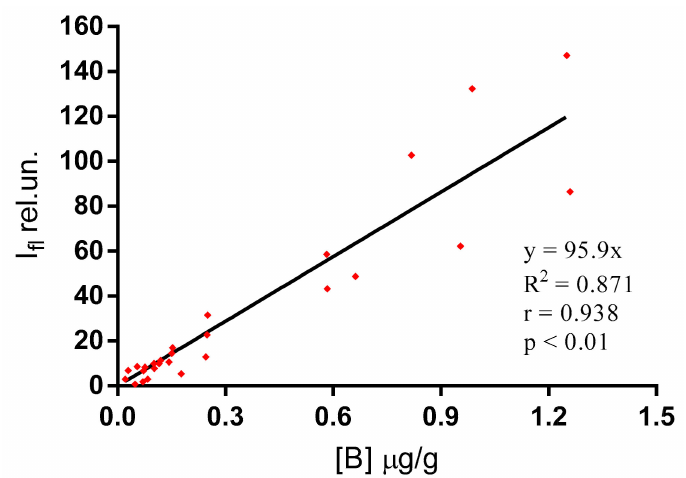
Figure 4. Correlation analysis of the CCDC fluorescence intensity (Ifl) and boron concentration [B] in the studied tissues. Joined data obtained for tumor, muscle, and liver are presented. Spearman’s rank correlation coefficient r = 0.938; significance level p < 0.01.